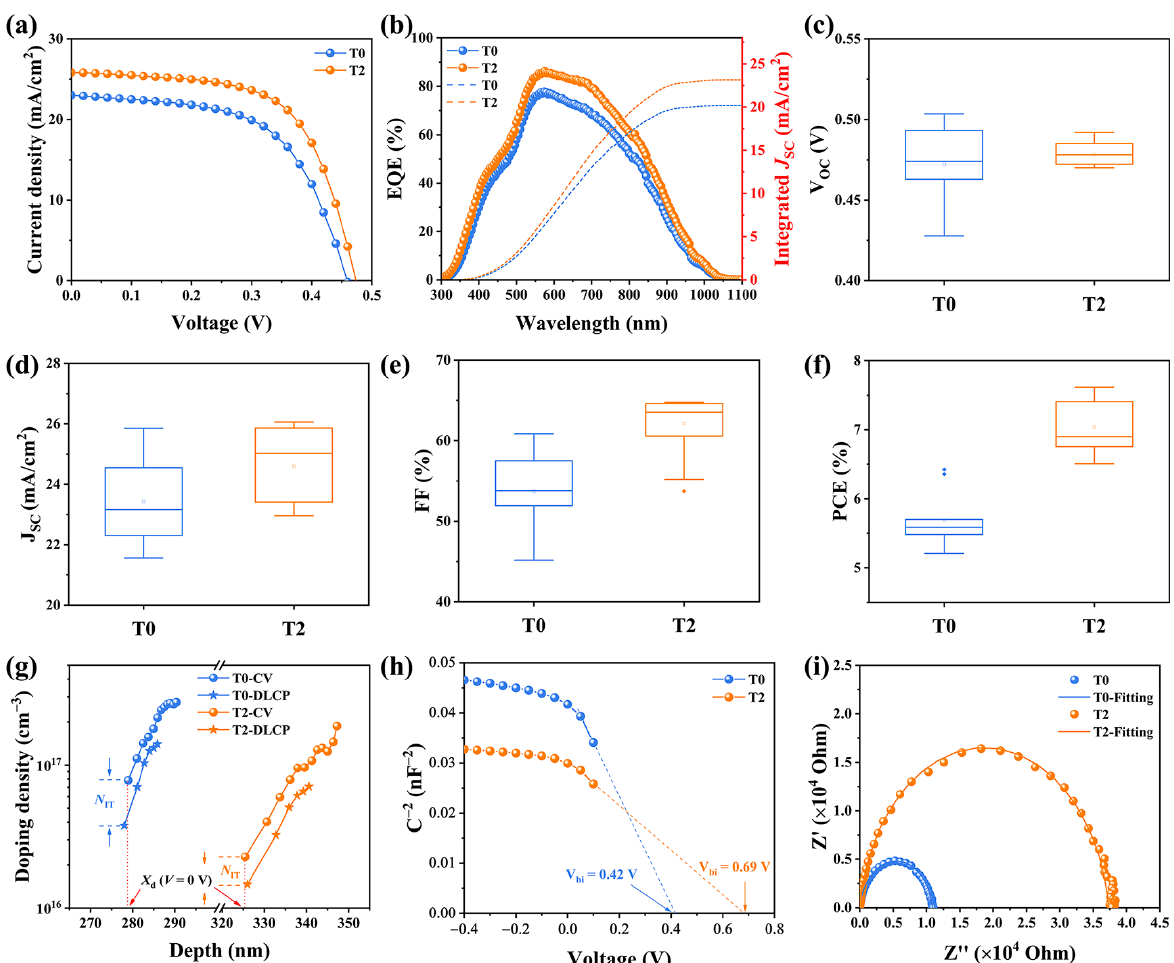
Figure 5. ( a ) The J -V curves, and ( b ) the EQE spectroscopy of the T0 and T2 devices. Statistical distribution of the photovoltaic parameter of the T0 and T2 devices, involving ( c ) V OC , ( d ) J SC , ( e ) FF, and ( f ) PCE. ( g ) CV and DLCP characterization of the T0 and T2 devices, and ( h ) Plots of C − 2 against V. ( i ) Nyquist plot of the T0 and T2 devices. Table 3. Device characteristics of the Sb 2 Se 3 solar cells with or without Te doping.